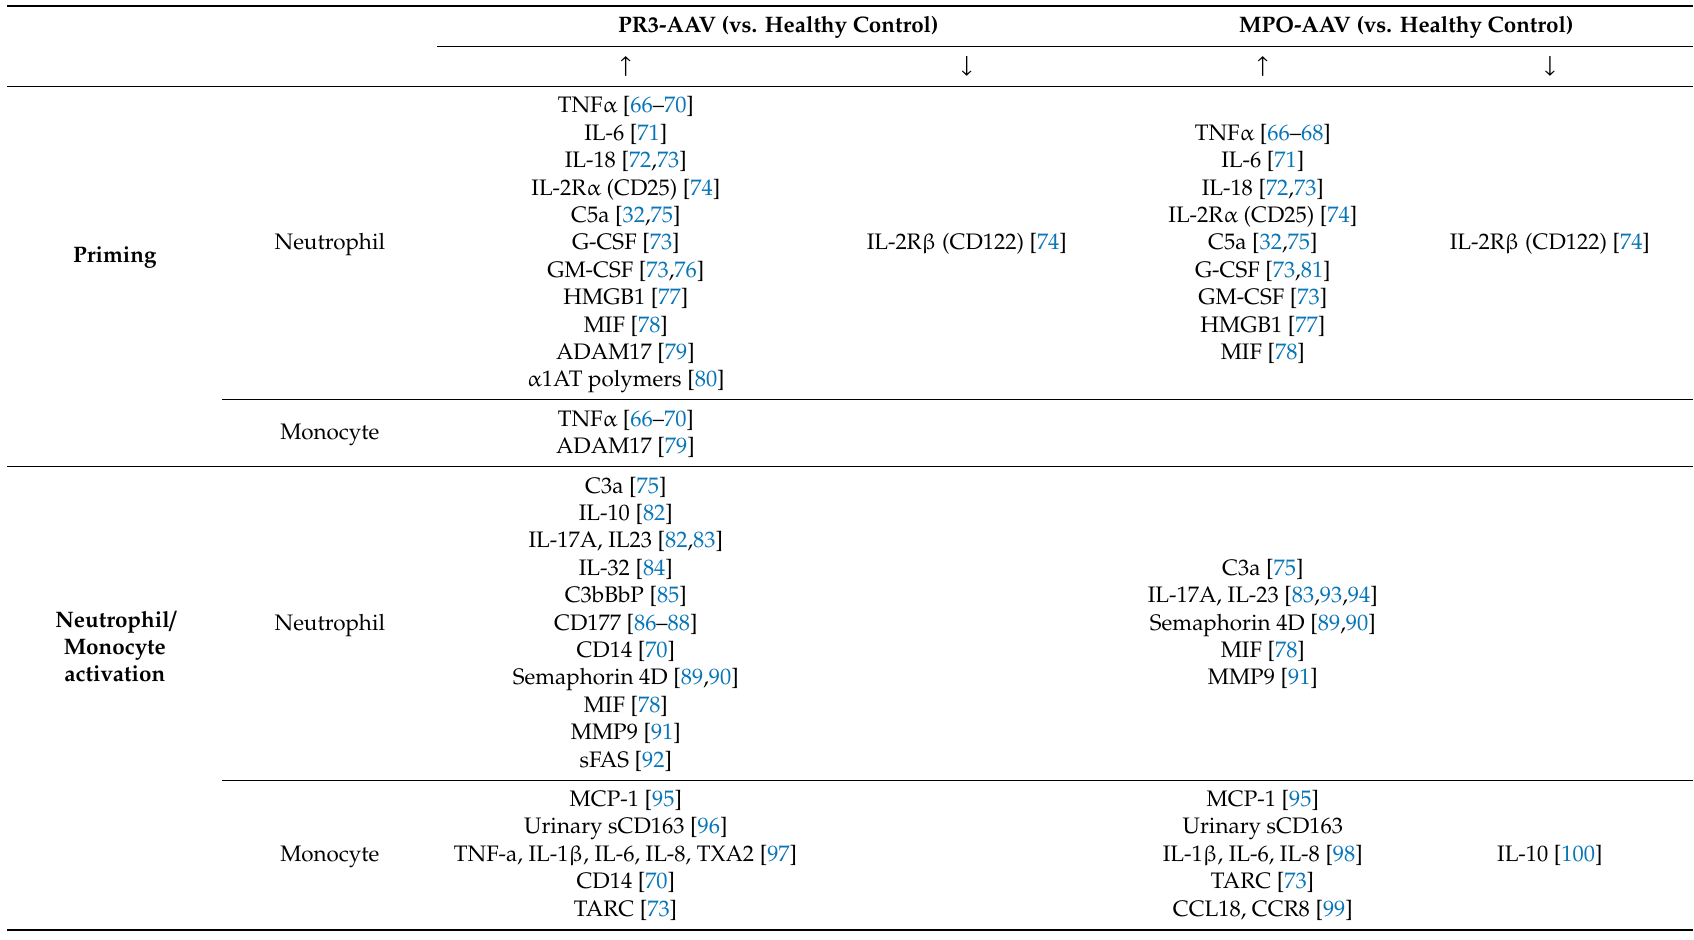
Table 1. Summary of inflammatory molecules and their expression status in ANCA-associated vasculitis (AAV) classified by ANCA specificity (PR3- or MPO- AAV) and